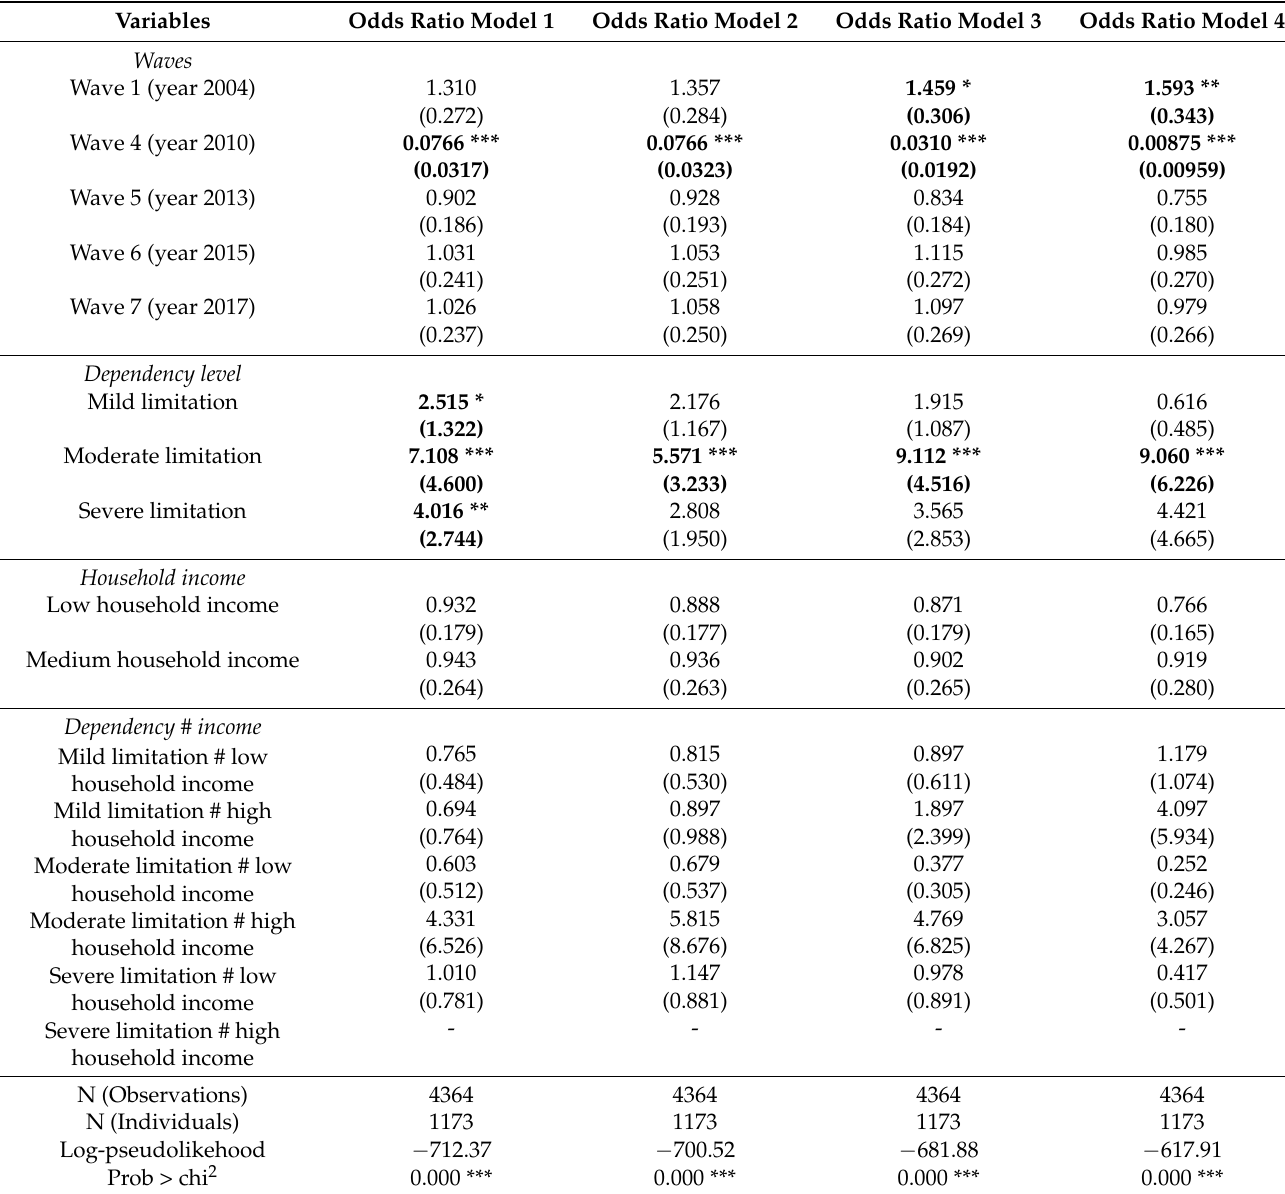
Table 3. Results from the logit regressions with random effects on formal care